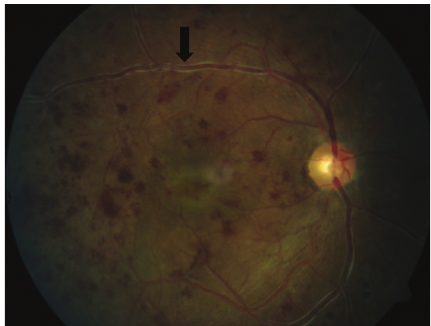
Figure 2: Ophthalmologic findings in the presented case. Optic disk of the left eye is shown. Perivenous sheathing is indicated (black